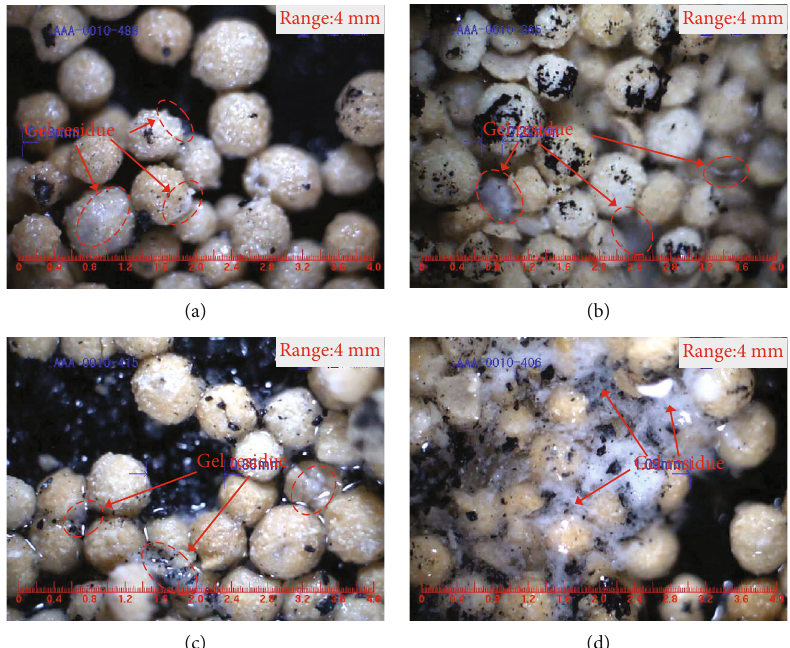
Figure 7: Residues of HPG fracturing fl uid with di ff erent concentrations in ceramic proppant pack. (a) 0.1% HPG. (b) 0.2% HPG. (c) 0.3% HPG. (d) 0.4% HPG.